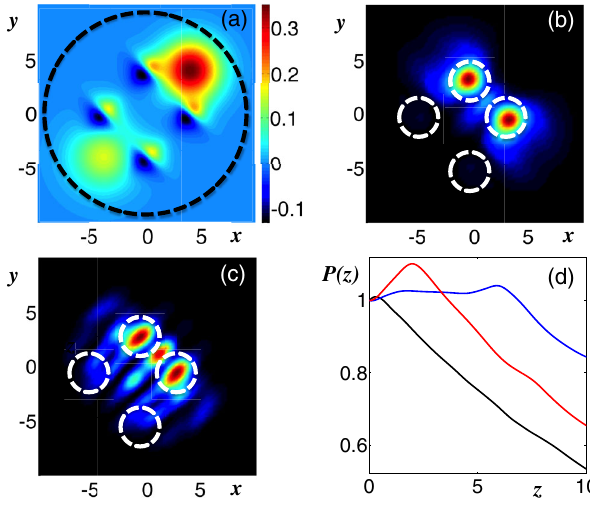
FIG. 11. (a) Spatial profile of a 2D non-normal optical potential in the transverse x - y plane. The real part of the refractive index is a constant inside the dashed black curve, and its imaginary part is given by the color scheme: Positive values represent the lossy regions, whereas the negative values represent the gain regions. (b,c) intensity of optimal initial conditions for achieving maxi- mum transient growth at z ¼ 2 ; 6 , respectively. The dashed white circles represent the gain spatial regions. (d) Power dynamics versus the propagation distance z for three different input waveforms. The black curve represents an intuitive waveform localized inside the gain regions. The red and blue curves represent the optimal waveforms shown in (b,c) that achieve the maximum growth at z ¼ 2 ; 6 ,